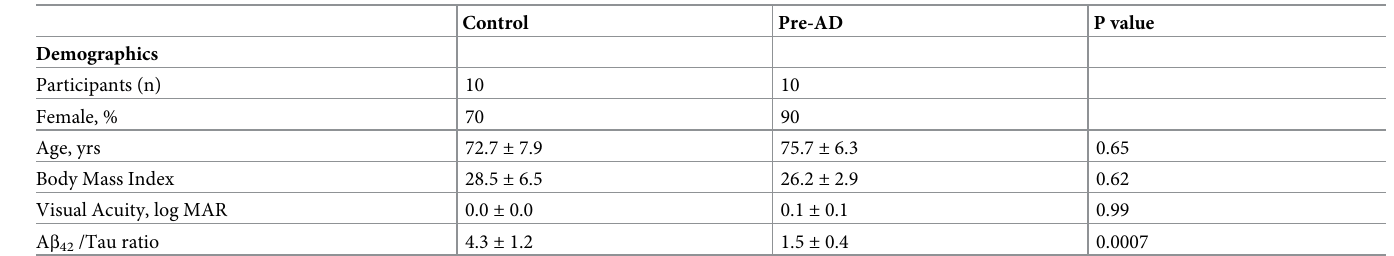
Table 1. Demographic data of pre-AD disease participants and